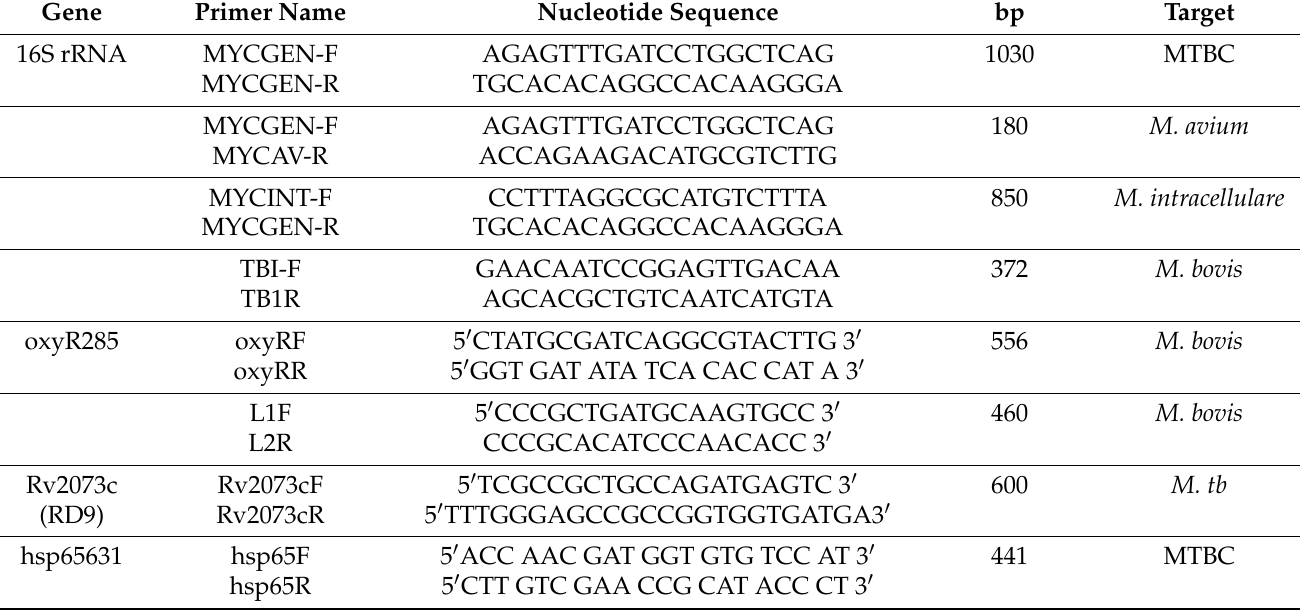
Table 1. Nucleotide sequence and expected product size f primers used in the PCR reaction for the detection of mycobacterial Nucleic acids in wild boar and wild